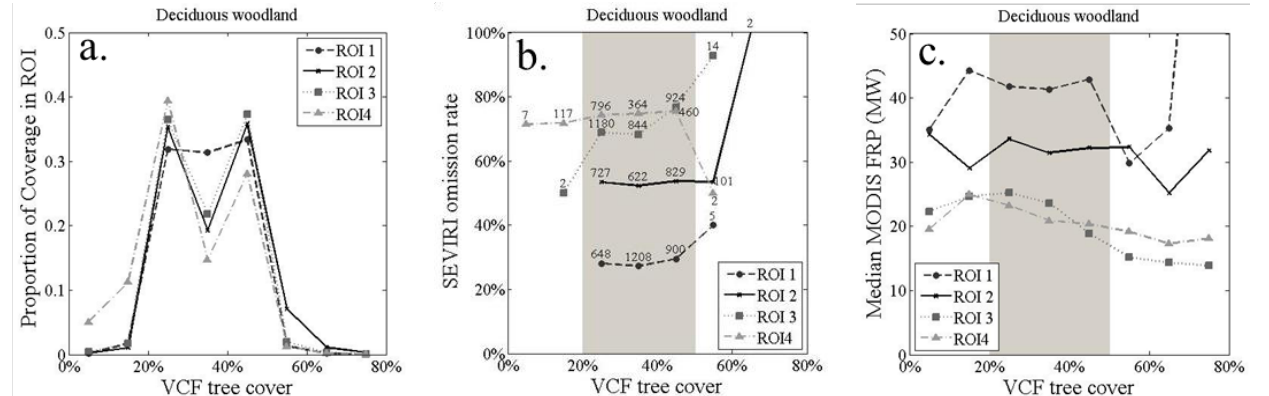
Figure 9. SEVIRI’s detection performance and MODIS’ measurements of FRP in the “Deciduous woodland” landcover class [64] stratified by vegetation continuous fields (VCF) percent tree cover [65]. Distributions of 500 m VCF percent tree cover in the “Deciduous woodland” degraded to 3 km resolution are shown in ( a ). SEVIRI’s active fire errors of omission as a function of percent tree cover in “Deciduous woodland” are shown in ( b ). Note that numbers in (b) represent the count of SEVIRI thermal pixels used to calculate SEVIRI’s omission rate, and that 93% of SEVIRI active fire pixels were detected under 20%–50% tree cover (shaded). The median FRP measured by MODIS in “Deciduous woodland” is presented as a function of tree cover in ( c